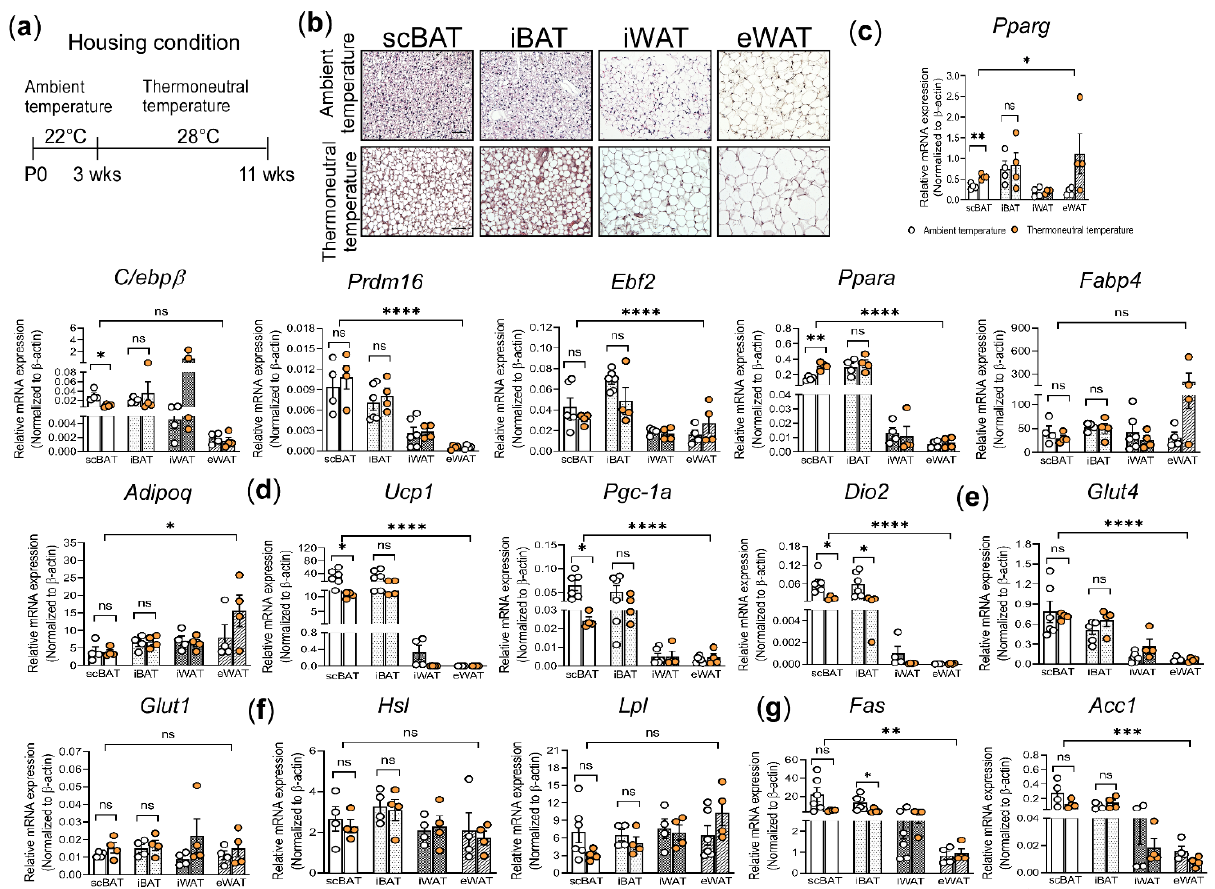
Figure 3. The effect of thermoneutrality on the adipocyte morphology and gene expression in scBAT, iBAT, iWAT, and eWAT. ( a ) Schematic diagram of the thermoneutral housing study design. Mice were housed at the thermoneutral temperature for 8 weeks. ( b ) Representative images of H&E-stained sections of scBAT, iBAT, iWAT, and eWAT from mice housed under ambient and thermoneutral temperatures. n = 3. Scale bar = 50 µm. ( c – g ) RT-qPCR analysis of adipocyte differentiation marker genes, thermogenic genes, glucose uptake genes, and lipid-processing genes in scBAT, iBAT, iWAT, and eWAT depots from mice housed under ambient and thermoneutral temperatures. ( c ) Adipocyte differentiation markers, Pparg , C/ebpβ , Ebf2 , Prdm16 , Pparα , Fabp4 , and Adipoq . ( d ) Thermogenic genes, Ucp1 , Pgc-1α , and Dio2 . ( e ) Glucose transporters, Gult4 and Glut1 . ( f ) Lipid uptake and processing genes, Lpl and Hsl . ( g ) Lipogenesis genes, Fas and Acc1 . The expression of these genes is normalized to the housekeeping gene β-actin. Data are presented as mean ± SEM. n = 4–6. for each group. * p < 0.05, ** p < 0.01, *** p < 0.001, **** p < 0.0001, ns = nonsignificant.